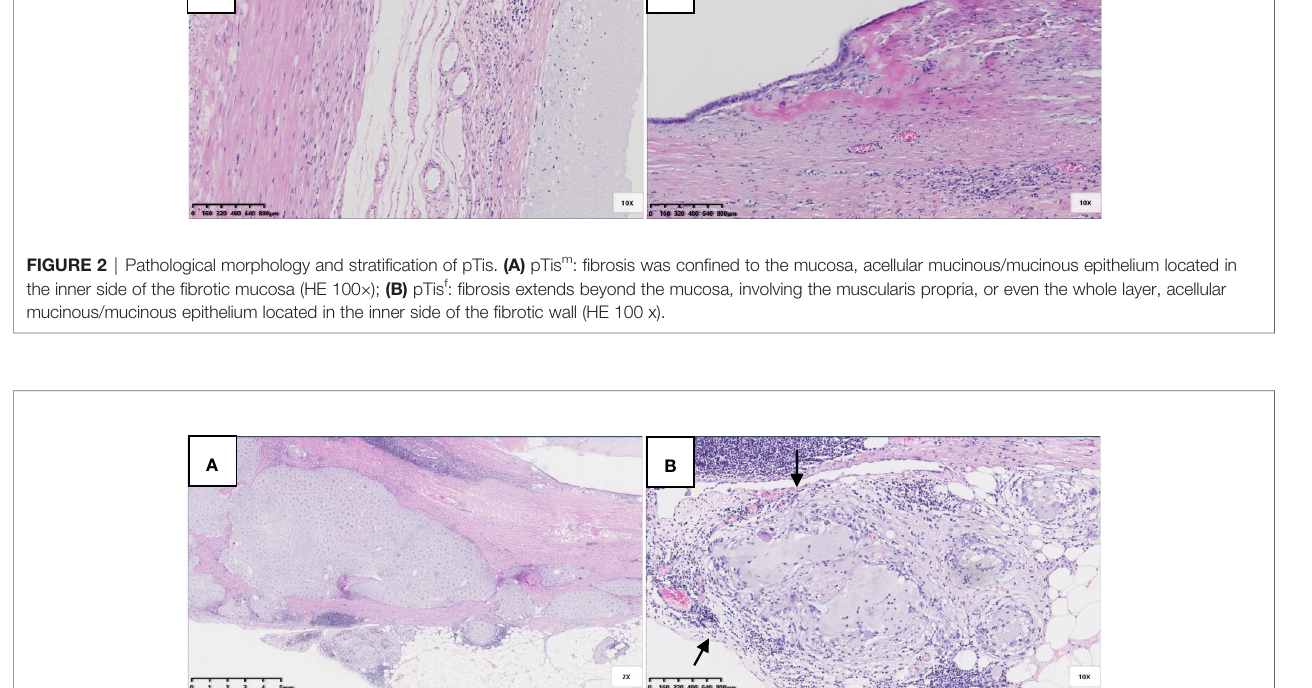
FIGURE 3 | Pathological morphology of pT3. (A) pT3: fi brosis of appendix wall, acellular mucinous invaded subserosa or mesoappendix (Hex) 20x); (B) A complete serosa layer can be seen (black arrow) (HE 100x).